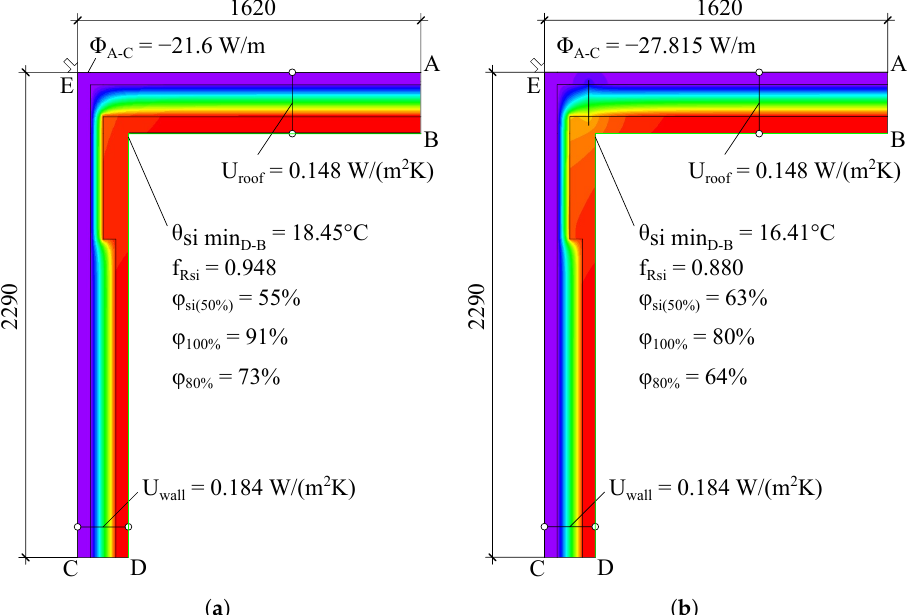
Figure 8. Temperature distribution in the top corner of the wall: ( a ) without steel connector, ( b ) with steel connector. Colour palette: from − 10 ◦ C (violet) to 20 ◦ C